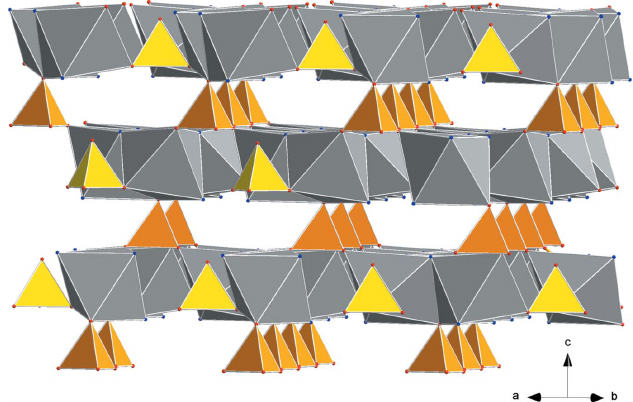
Figure 8 Interconnections of sodium layers by sulfate tetrahedra with the S2 sulfur atom (dark